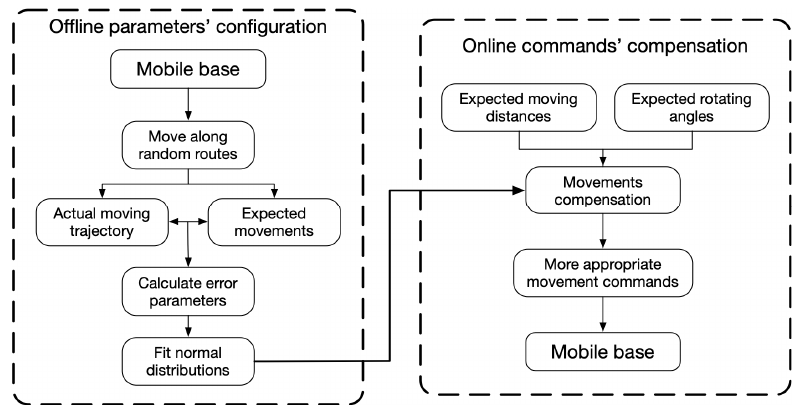
Figure 18. Flowchart for the movement command compensation.